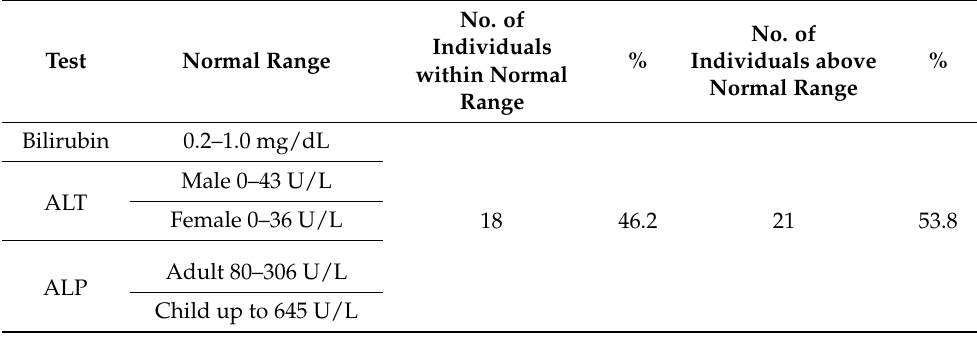
Table 5. In this table, bilirubin, ALT, and ALP levels in the serum of HBV-positive individuals discriminate between healthy and damaged liver patients.